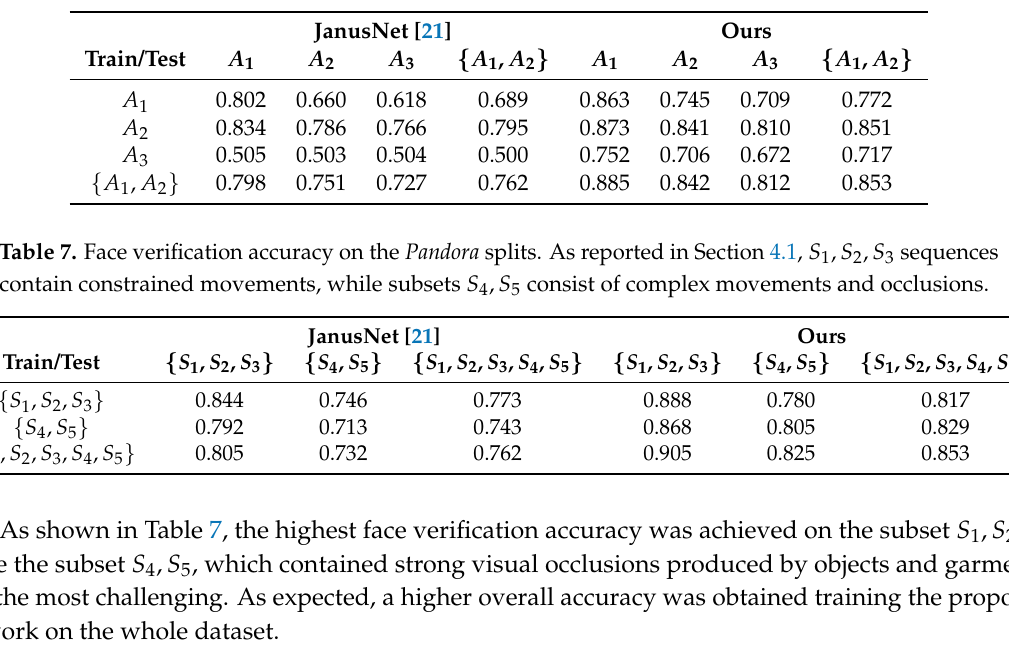
Table 6. Face verification accuracy on the Pandora splits. As reported in Section 4.1, the A 1 subset contains frontal head poses only, while A 2 and A 3 contain non-frontal poses, including extreme angles